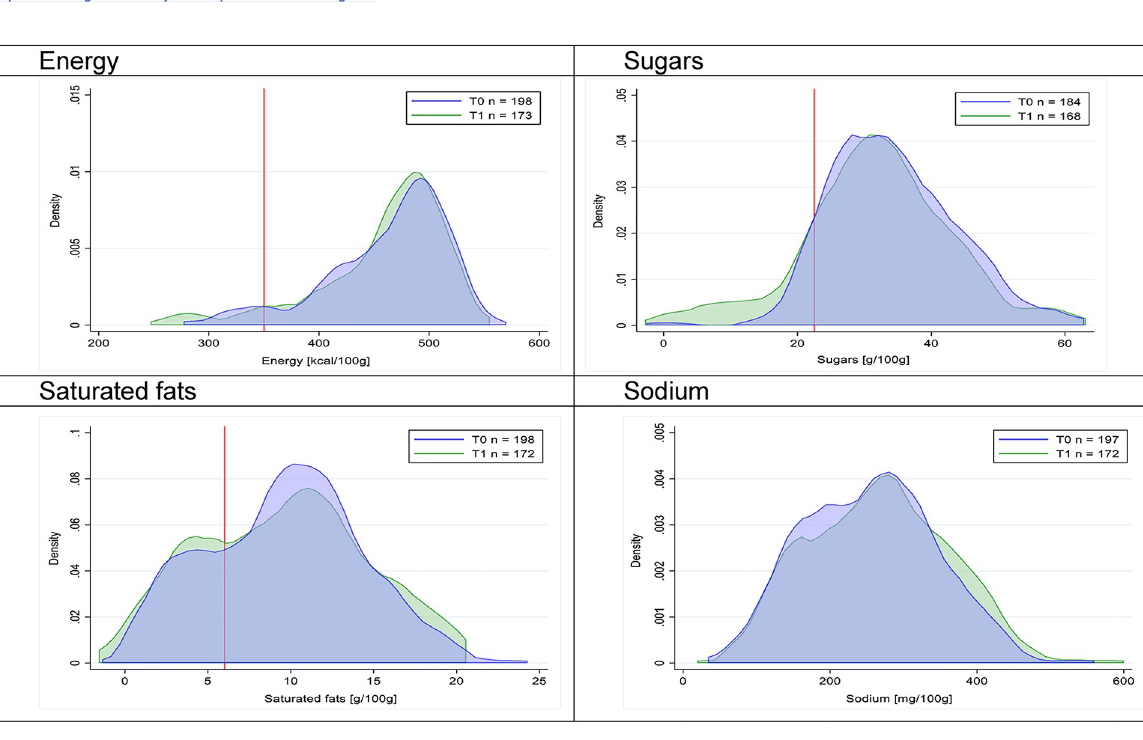
Fig 6. Density curves for the amount of energy and nutrients of concern in sweet baked products, cross-sectional samples. The blue line represents the distribution in T0 (preimplementation), the green line represents the distribution in T1 (postimplementation), and the red line represents the cutoff for the amount of energy or nutrients of